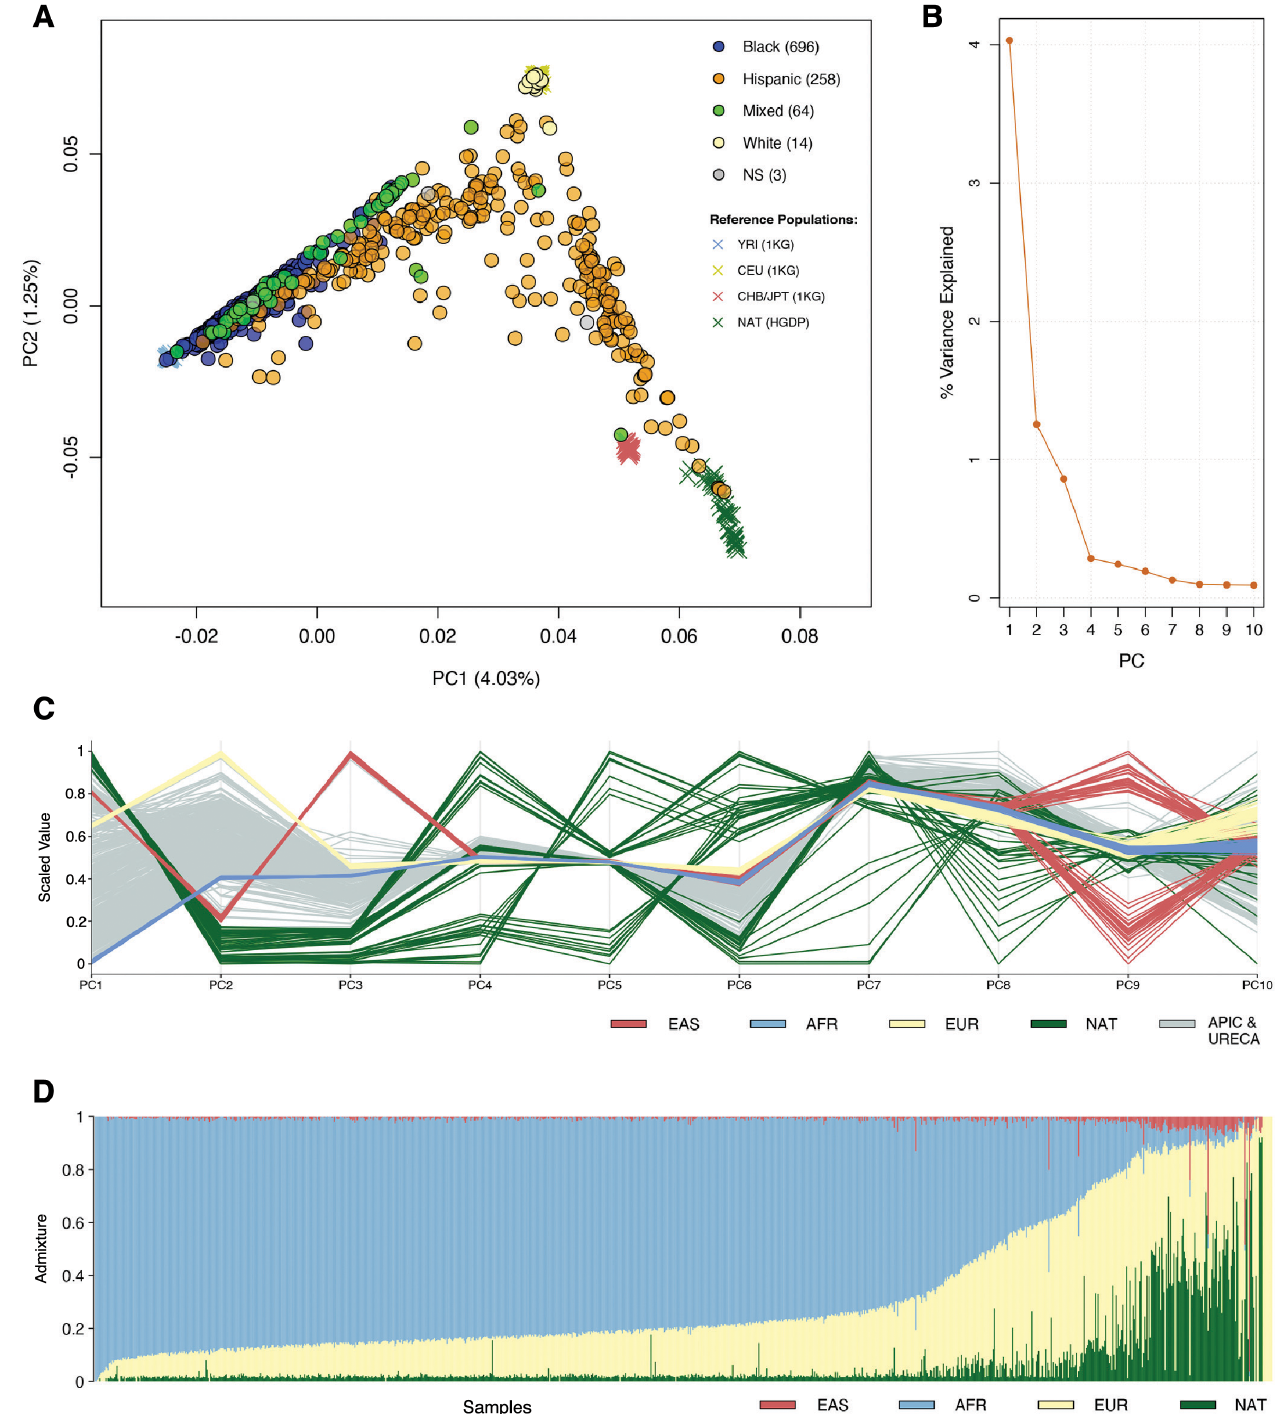
Fig 1. Ancestry composition of sequenced APIC & URECA participants. A) The top two principal components (PCs) of ancestry are plotted for sequenced APIC & URECA participants, colored by self-identified race/ethnicity, along with the four ancestry reference populations used for determining ancestry. NS = not specified. B) The proportion of genetic variance explained by each of the top 10 PCs. C) The relative values of the top 10 PCs are plotted for each sample, colored by reference population. D) The estimated proportion of admixture from each ancestral population is shown for each sequenced APIC & URECA participant. Each vertical line corresponds to one sample. 1KG, 1000 Genomes project; HGDP, Human Genome Diversity Project; YRI, Yoruba in Ibadan, Nigeria; CEU, Utah residents with Northern and Western European ancestry; CHB, Han Chinese in Beijing, China; JPT, Japanese in Tokyo, Japan; NAT, Native Americans from HGDP; EAS, East Asian ancestry; AFR, African ancestry; EUR, European ancestry.